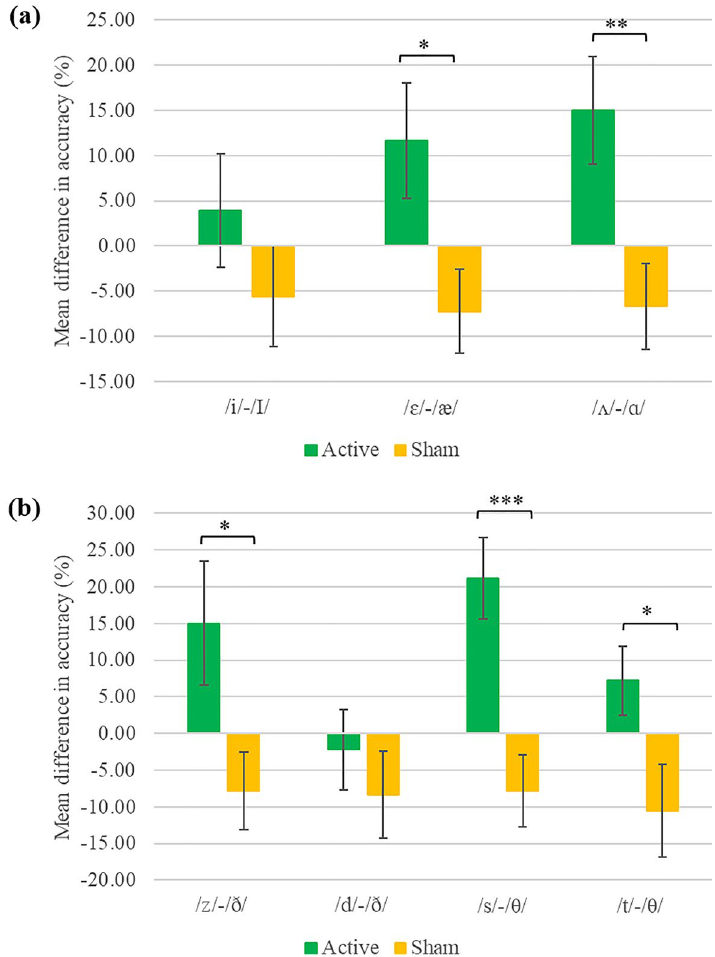
Figure 2. Difference scores in discrimination accuracy (%) of phoneme contrasts following active and sham stimulation. ( a ) Represents vowel contrasts and ( b ) consonant contrasts. Mean difference was calculated by subtracting post-training scores from pre-training scores. Error bars represent standard error of the mean. * p < .05, ** p < .01, *** p < .001.